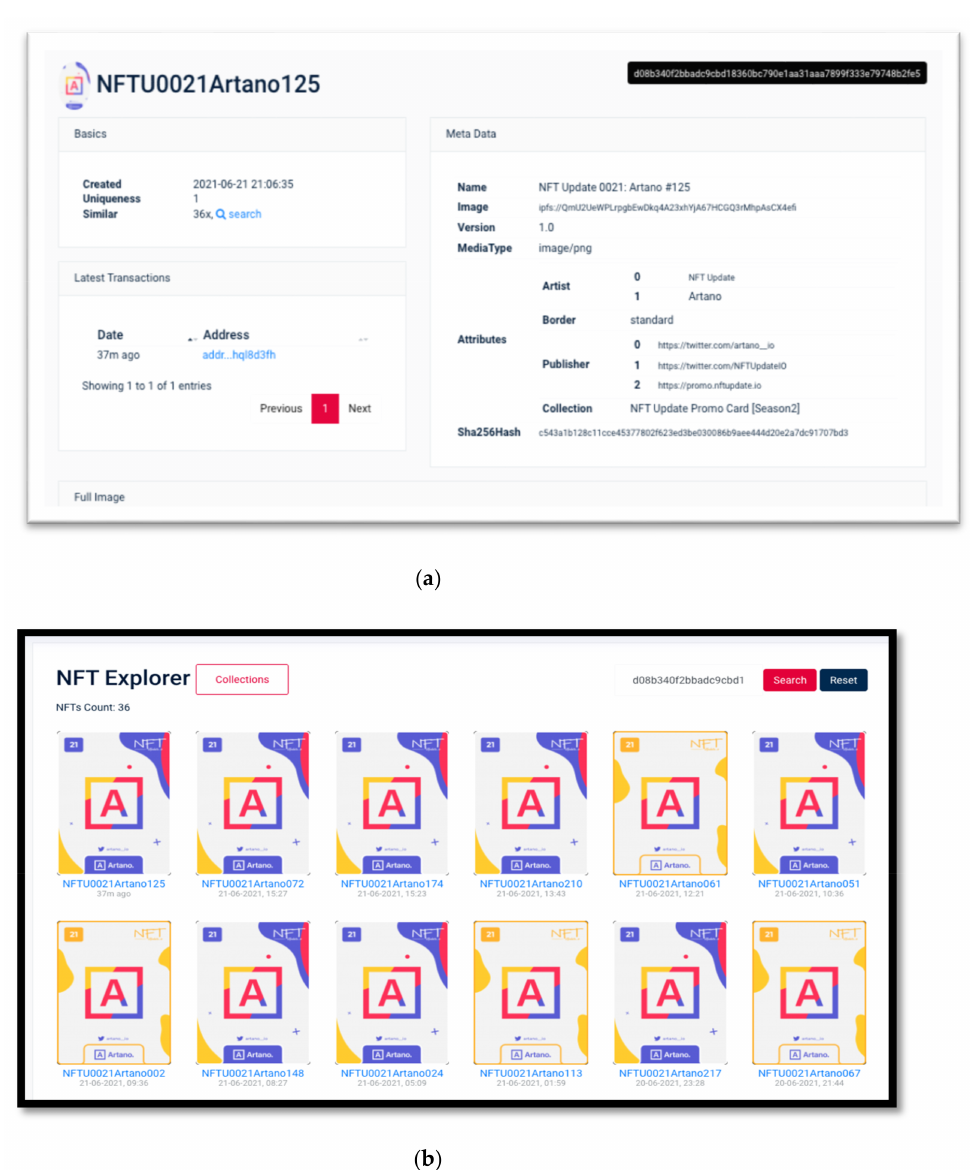
Figure 2. This is a figure. Schemes follow another format. If there are multiple panels, they should be listed as: ( a ) An example of a public NFT record; ( b ) A search from the “Similar” link on Figure 1. Source: